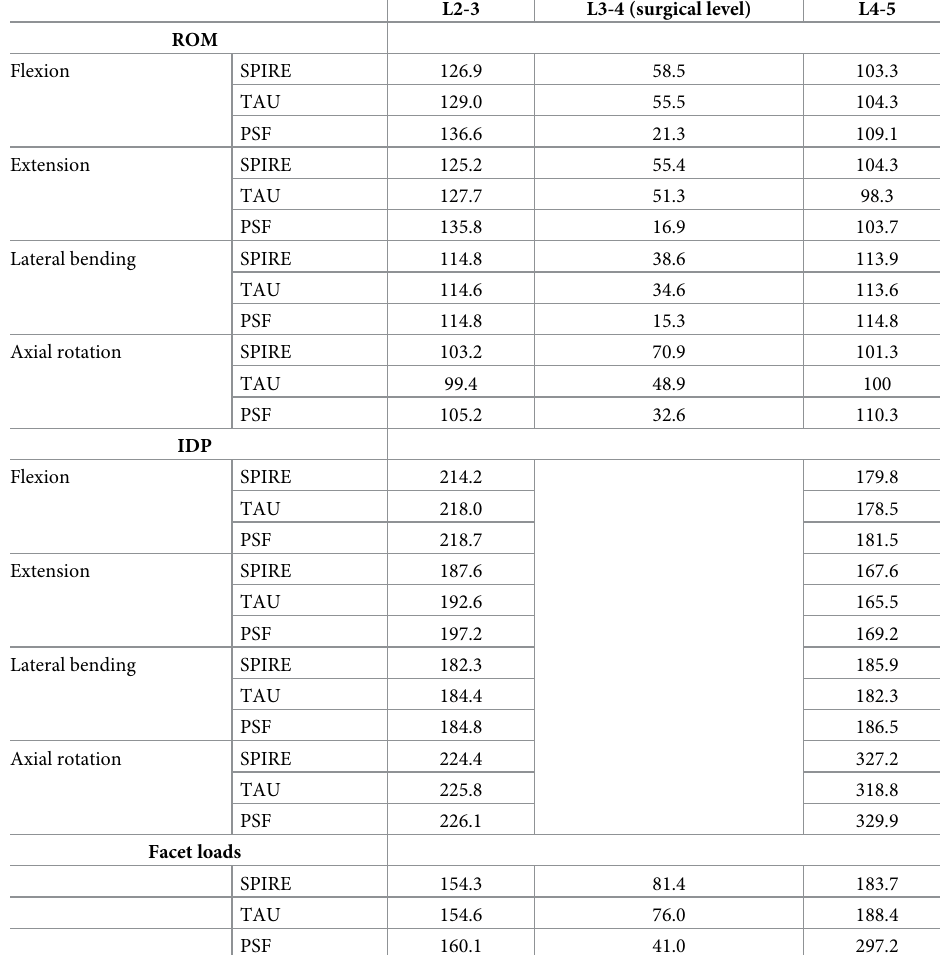
Table 2. Biomechanical parameters among various surgical devices (Data were normalized with respect to the intact model as percentage